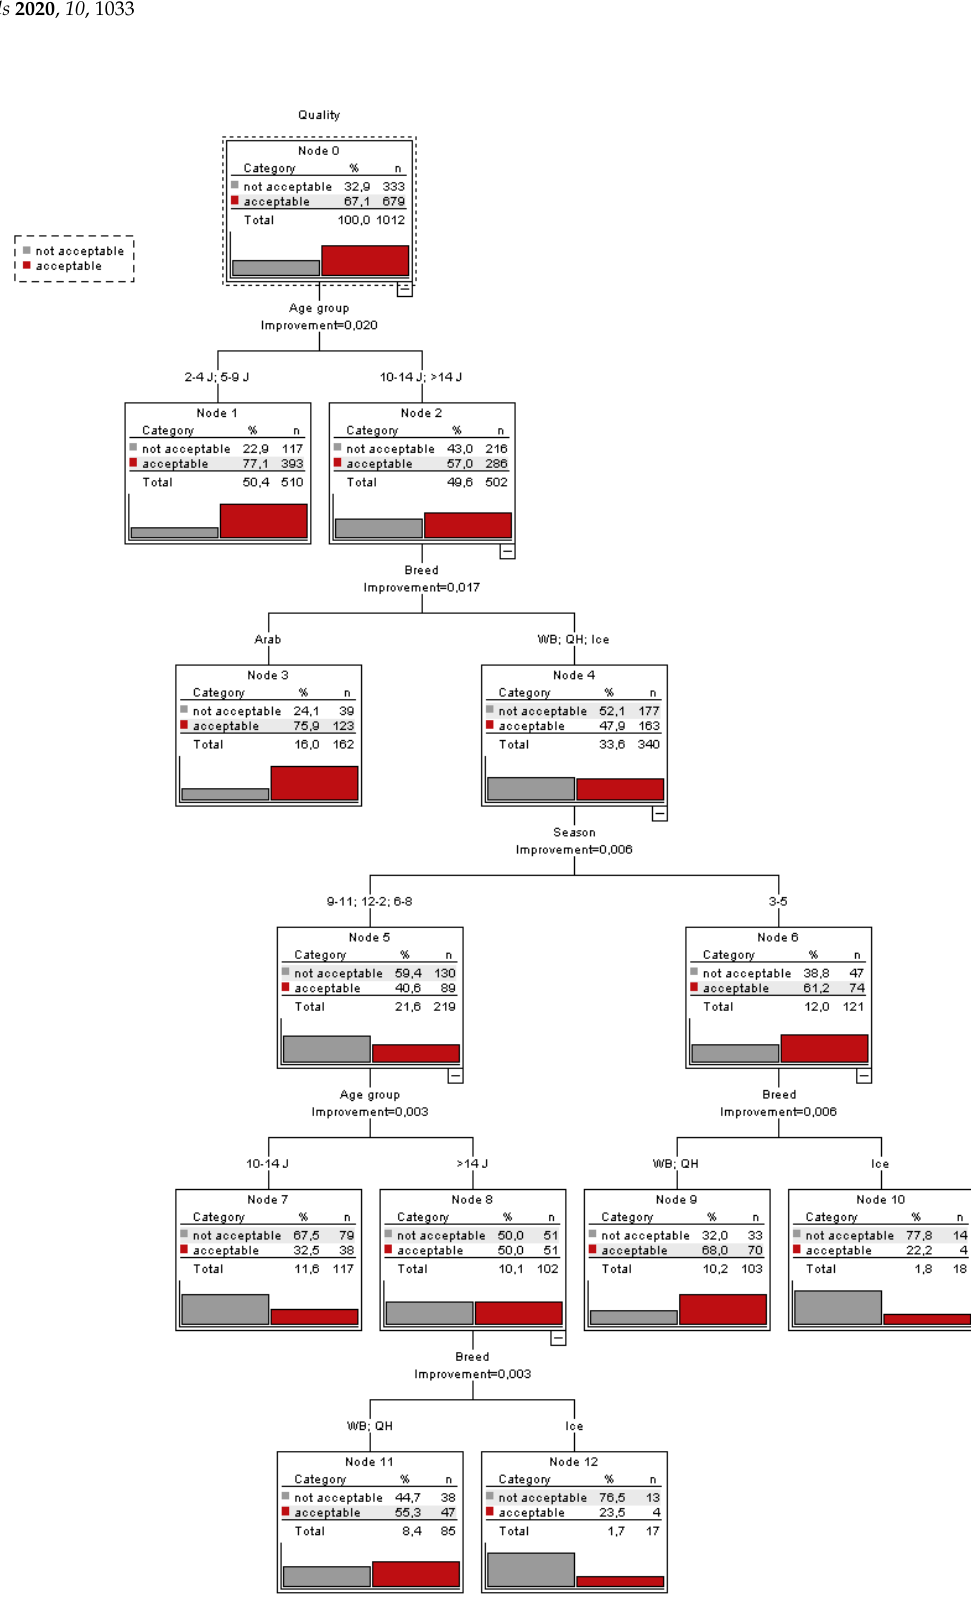
Figure 2. Classification tree prediction percentage of acceptable and non-acceptable ejaculates after cryopreservation determined by age group and breed of the stallion. No seasonal effect was shown.